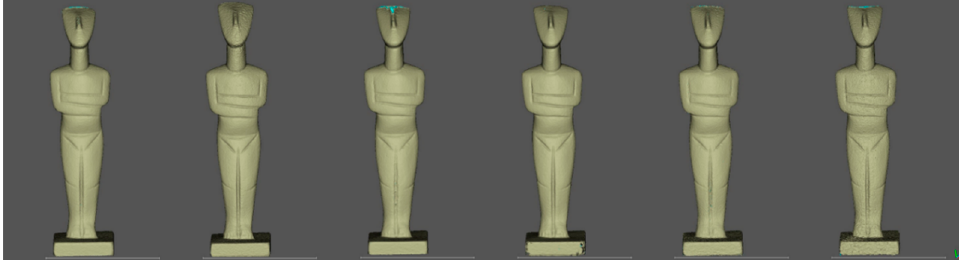
Figure 6. Untextured photogrammetric meshes of the figurine copy, (from left to right) dataset 1 AMP, dataset 1 FZA, dataset 2 AMP, dataset 2 FZA, dataset 3 AMP, dataset 3 FZA. Table 10. Hausdorff distances between the photogrammetric models for the figurine copy case study—datasets 1–3 (distances in